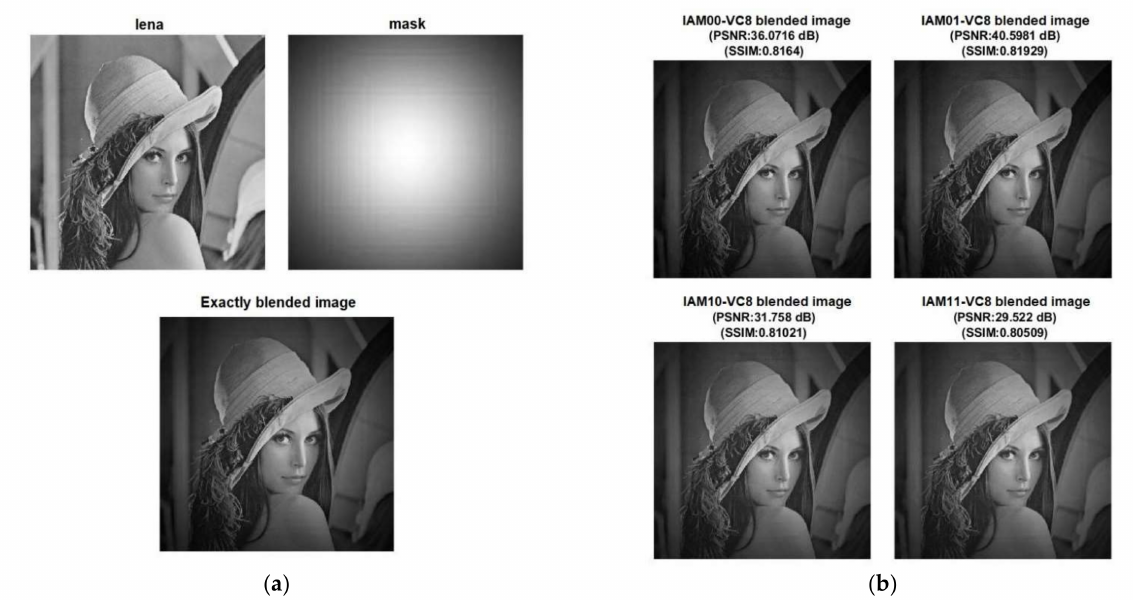
Figure 4. ( a ) Lena and mask images, and the exactly blended image. ( b ) Blended images obtained using various inexact array multipliers (IAM00-VC8, IAM01-VC8, IAM10-VC8, and IAM11-VC8) based on vertical cut VC8 made on the exact array